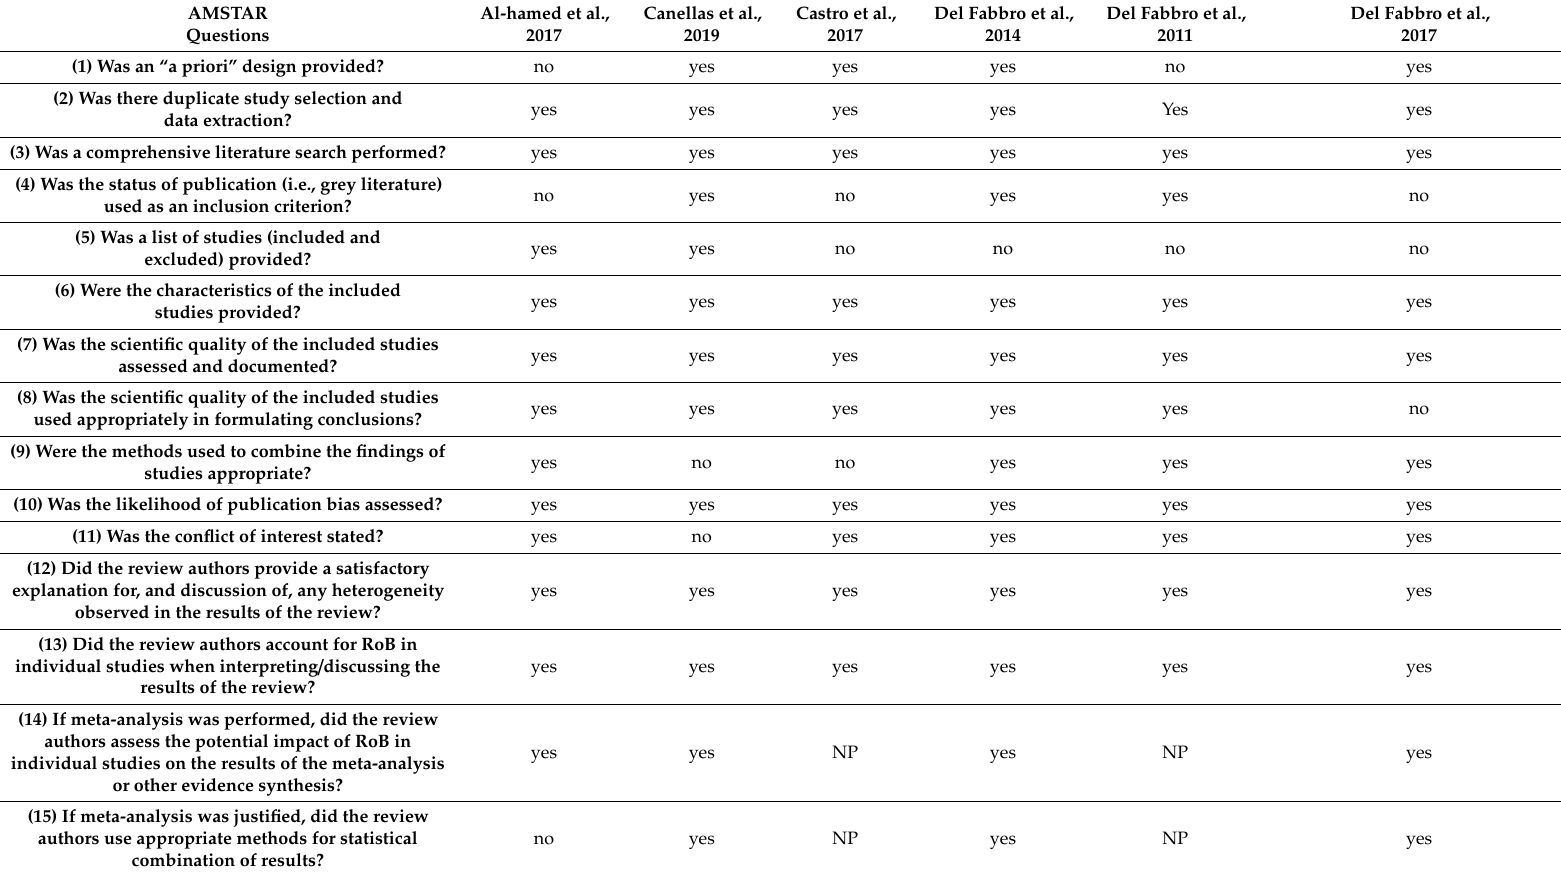
Table 2. Quality assessment checklist for systematic reviews (AMSTAR